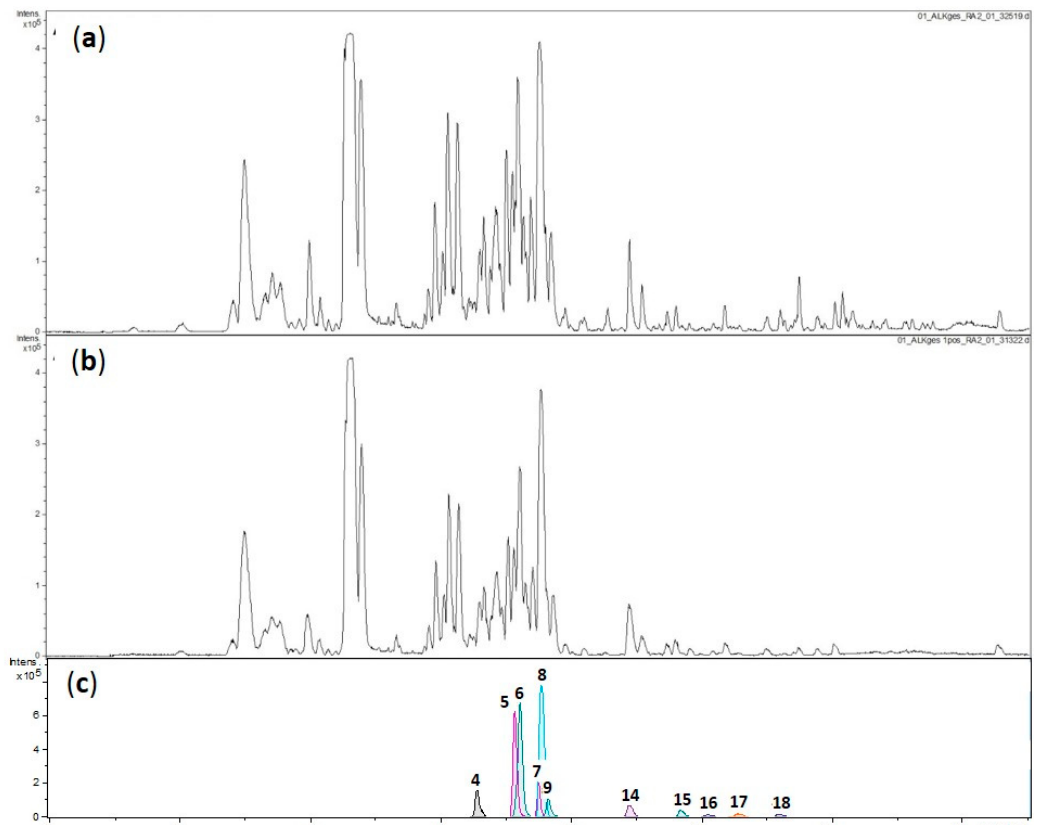
Figure 1. LC–MS profiles (base peak chromatograms of m/z 50–1500) of PS_AEF ( a ) obtained from a small-scale extract and ( b ) from a larger scale extract of aerial parts of P. terminalis . Constituents highlighted by the partial least squares (PLS) model (compare Figure 2 and Table 2) are shown as dissect compound chromatograms in ( c ), obtained from the analysis shown in (b). Note that some of the compounds were too low in concentration to be detected at the crude extract level.